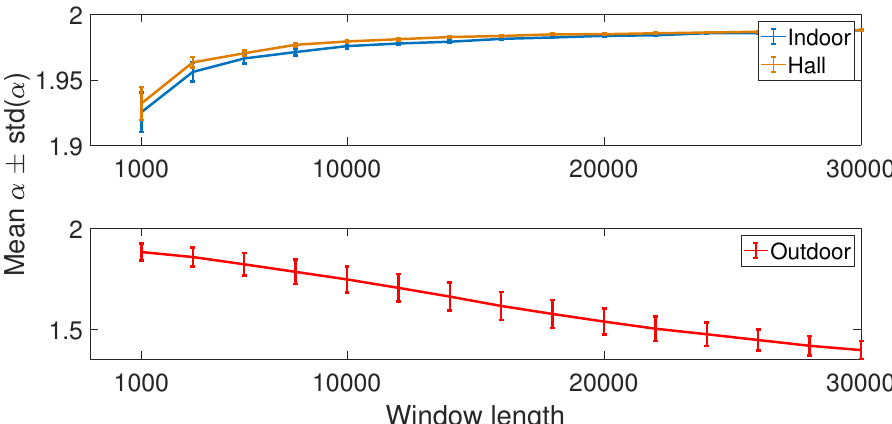
Figure 17. Variance of the estimated α parameter versus the window length.